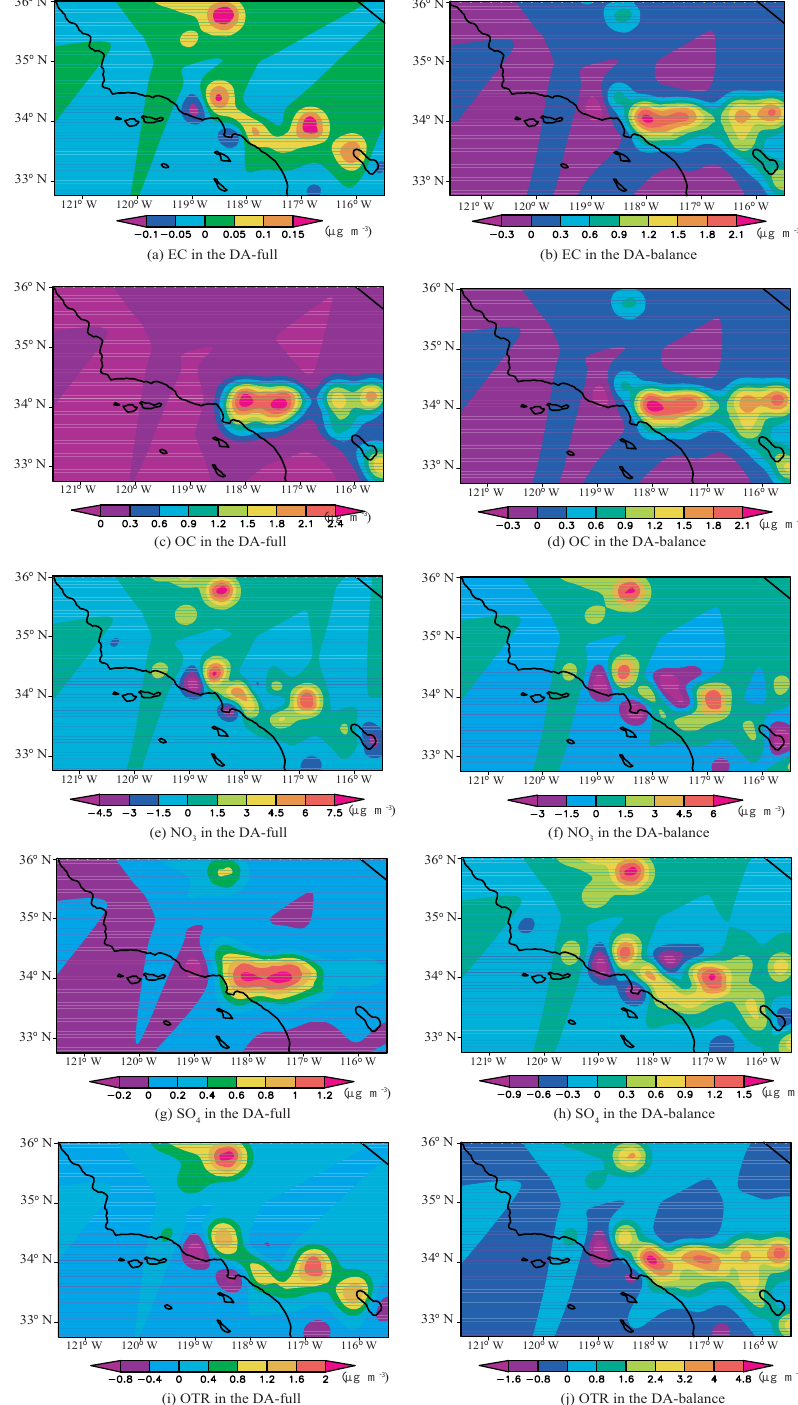
Figure 9. Surface distributions of increments of the five variables of EC, OC, NO 3 , SO 4 and OTR at 12:00UTC on 3 June 2010. The left column and right column are from DA-full and DA-balance,